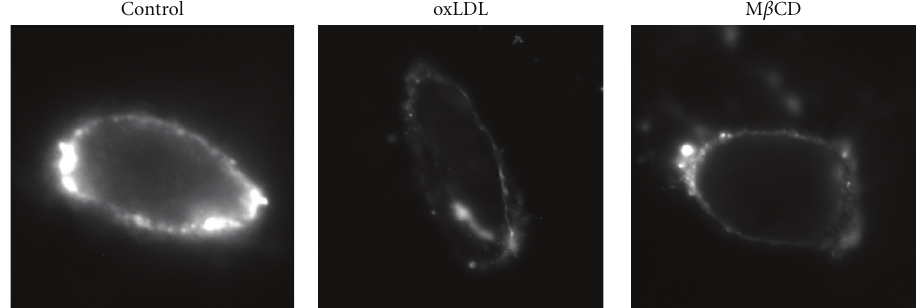
Figure 2: oxLDL indices internalization of GM1. Typical images of fluorescently labeled CTx staining in nonpermeabilized control, oxLDL-, and M β CD-treated bovine aortic endothelial cells showing the surface expression of G M 1 on the plasma membrane. Similar to the earlier studies, cells were exposed to 10 μ g/mL oxLDL for 1h at 37 ◦ C but the degree of LDL oxidation was a little lower (10–15 nmol/mg TBARS). For cholesterol depletion, cells were treated with 5mM M β CD for 1 hour, a treatment that typically decreases cellular cholesterol level by 50%. Adapted from